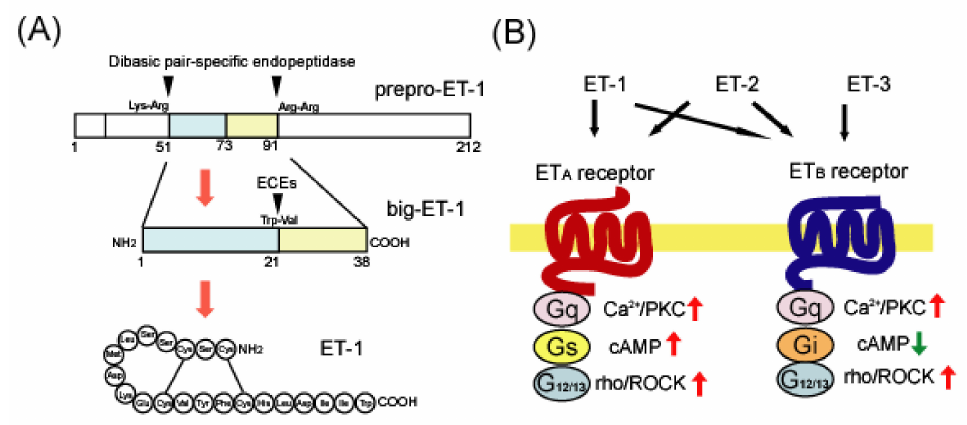
Figure 1. ( A ) Biosynthesis of human endothelin-1 (ET-1) from prepro-ET-1. ET-1 is translated as an inactive precursor protein called prepro-ET-1. Prepro-ET-1 is cleaved by dibasic pair-specific endopeptidases and converted to big-ET-1. Specific processing of big-ET-1 by endothelin-converting enzymes (ECEs) results in the production of mature ET-1. ( B ) Ligand preference and signal transduc- tion of ET A and ET B receptors. There are three distinct ET family peptides: ET-1, ET-2, and ET-3. The ET A receptor has a ligand preference for ET-1 and ET-2, whereas the ET B receptor binds these three ET ligands with a similar affinity. Both ET A and ET B receptors are linked to Gq- and G 12/13 -type G proteins, which activate Ca 2+ /protein kinase C (PKC) and rho/Rho-associated protein kinase (ROCK), respectively. ET A receptors are also linked to the Gs protein to trigger cAMP-mediated signals, whereas ET B receptors are linked to Gi to suppress